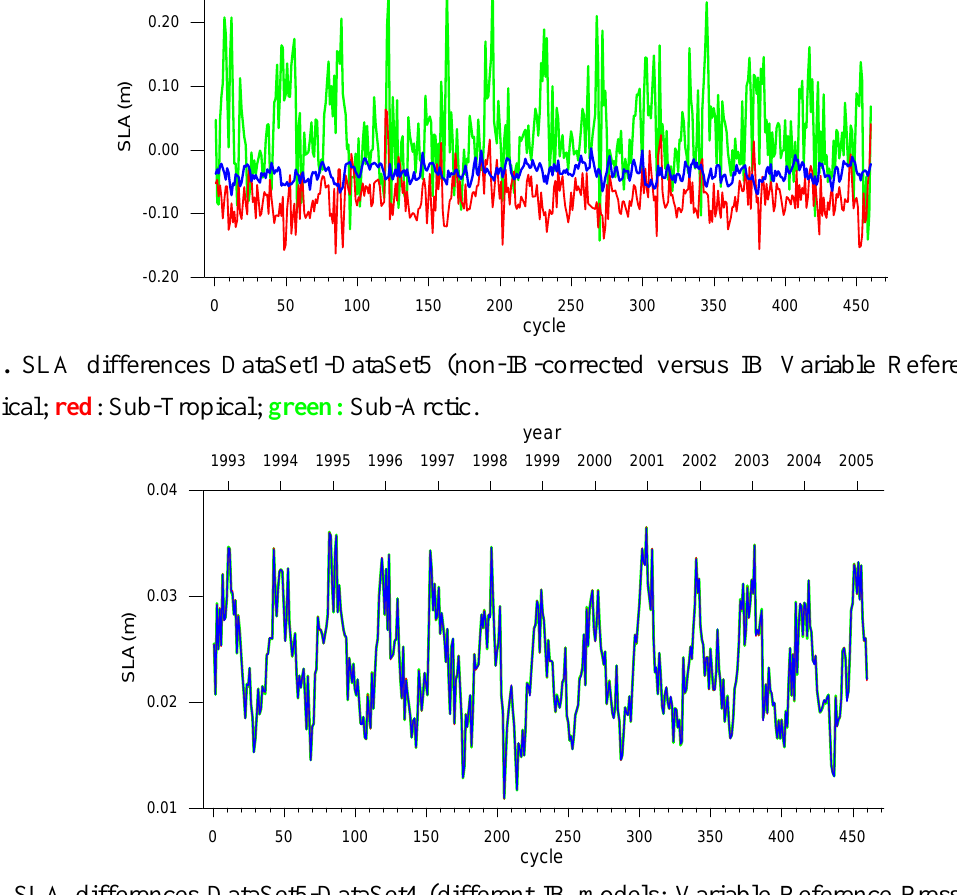
Figure 8a. SLA differences DataSet5-DataSet4 (different IB models: Variable Reference Pressure - Constant Reference Pressure) blue - Tropical; red : Sub-Tropical; green: